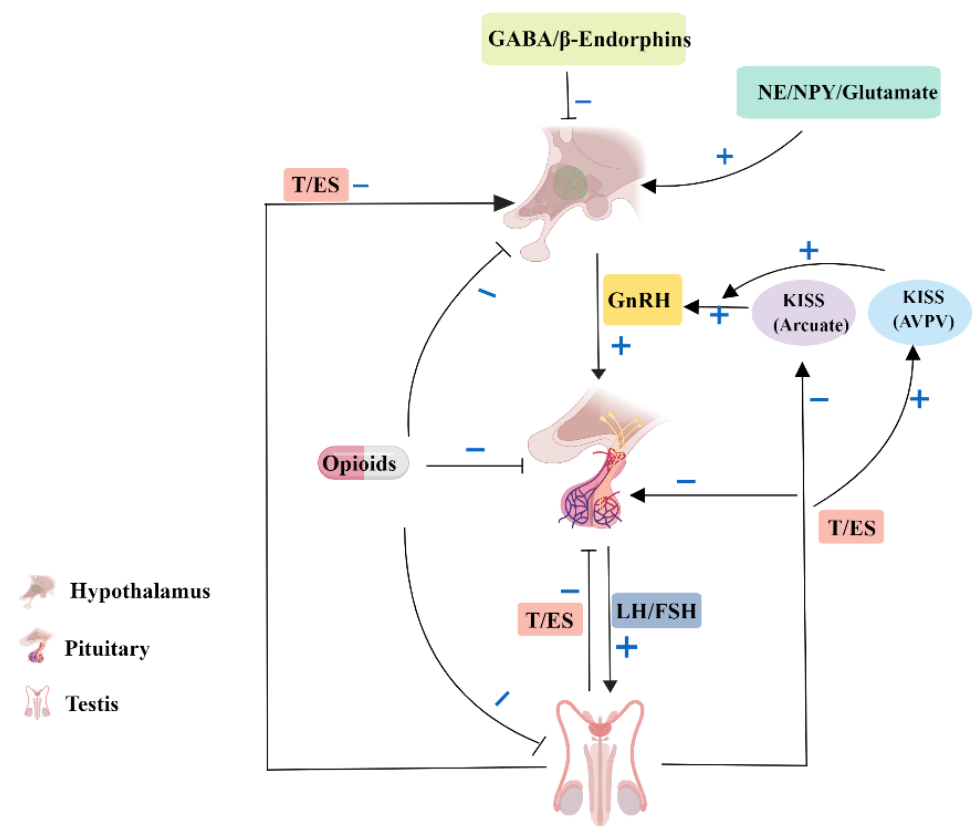
Figure 3. The regulation of the hypothalamic–pituitary–testicular axis. T, testosterone; ES, estradiol; NE, norepinephrine; NPY, neuropeptide; GABA, gamma-aminobutyric acid; GnRH, gonadotropin- releasing hormone; LH, luteinizing hormone; FSH, follicle-stimulating hormone; KISS, kisspeptin; AVPV, anteroventral periventricular nucleus.